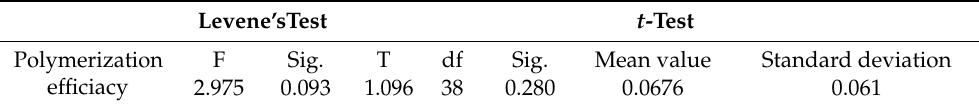
Table 4. Student’s t -test results, indicating the presence or absence of a statistically significant relationship between the polymerization efficacy and the cementitious material type.